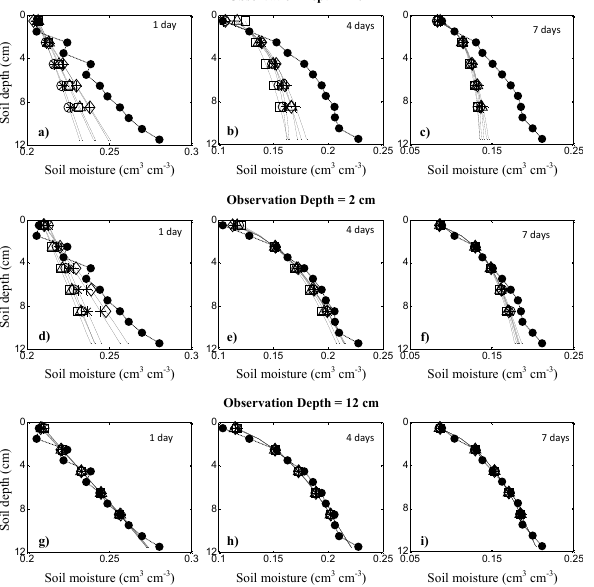
Figure 9. Retrieved soil moisture profiles (solid lines) using the GB1 data series after 1 day (a, d, g) , 4 days (b, e, h) and 7 days (c, f, i) , with assimilation frequency AF = 1/2h − 1 and observation depths: (a–c) OD = 1cm, (d–f) OD = 2cm, and (g–i) OD = 12cm. Comparisons account for the six pondered sets of initial parameters S1( (cid:13) ) , S2( (cid:3) ) , S3( ∗ ) , S4( 1) , S5( + ) and S6( ♦ ) . The dotted line with solid circles represents the measured profile.